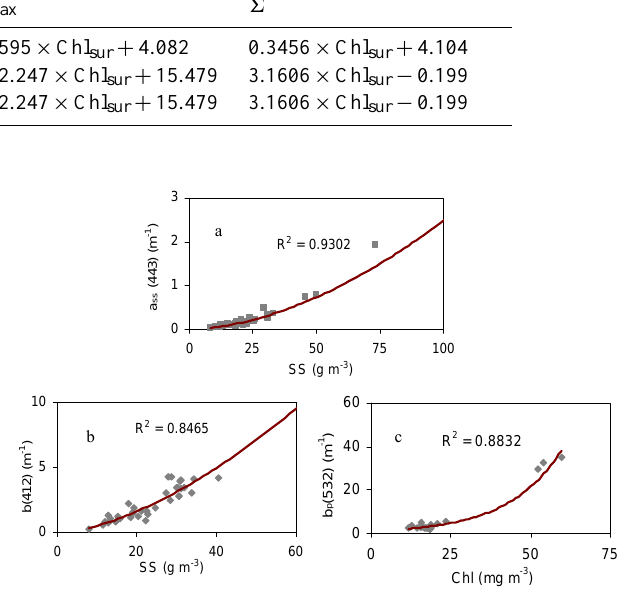
Figure 4. (a) Relationship between the suspended sediment concen- tration and absorption by suspended sediment a ss (443), used to cal- culate the absorption coefficient of suspended sediments a ss (443). (b) Relationship between the suspended sediment concentration and scattering b (412), used to calculate the scattering ( b ss ) coefficient of suspended sediments. (c) Relationship between the Chlorophyll and particulate scattering b p (532) which is used to calculate the partic- ulate scattering directly from the chlorophyll concentration. This is applicable only for surface Chl should it be greater than 15mgm − 3